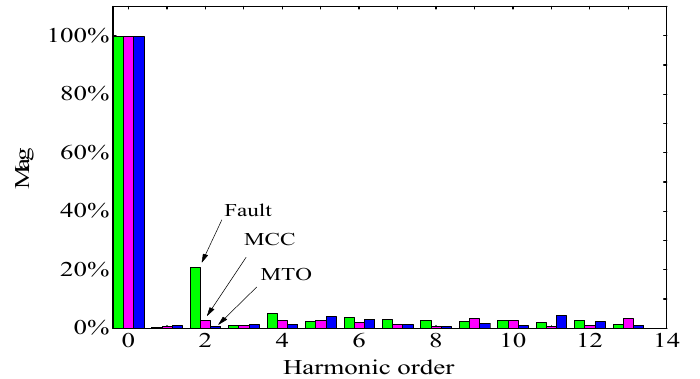
Figure 12. Torque FFT analysis.